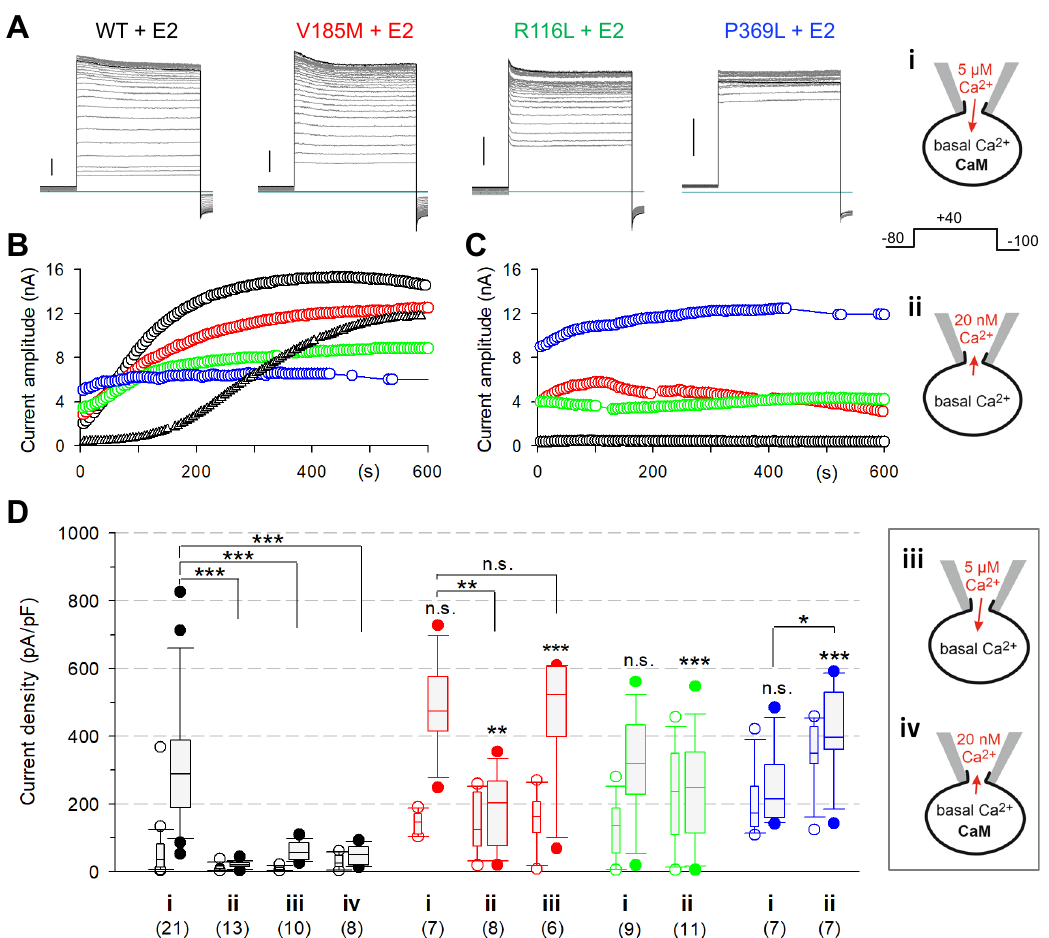
Figure 6. High intracellular Ca 2+ -CaM levels counteract the differences in current densities between WT and mutant Q1E2 channels. Whole-cell recordings performed in standard Ringer on cells co- expressing KCNE2 with WT or mutant KCNQ1. In two sets of experiments, CaM was additionally co-expressed (condition i and iv, see schematic drawings). The ICS contained either a high (i and iii) or a low (ii and iv) Ca 2+ concentration. ( A ) Overlays of the first and then every fourth current trace recorded with 500 ms test pulses to 40 mV from cells co-expressing CaM and using high-Ca 2+ ICS (“i”). The respective last trace within 10 min after establishing the whole-cell configuration is shown in black. Vertical bars denote 2 nA. ( B ) Time course of current amplitudes for the experiments shown in ( A ) (open circles). In addition, a second WT Q1E2 experiment is given (black triangles) to illustrate the variability in the time courses of the current increase. ( C ) Time course of current amplitudes from exemplary experiments performed with standard condition “ii”. ( D ) Boxplot of initial Q1E2 current densities (thin boxes, open circles for all outliers) and maximal Q1E2 current densities (broad boxes, filled circles for all outliers) obtained in differing experimental conditions (i–iv). Color code as shown in ( A ). Asterisks directly above a box indicate significant differences in maximal current density for the mutant Q1E2 compared to WT Q1E2 data obtained under the same experimental conditions. Other asterisks indicate significant differences in maximal current density between condition “i” and another recording condition. *** p < 0.001; ** p < 0.01; * p < 0.05; n.s., not significant. Numbers of experiments are given in